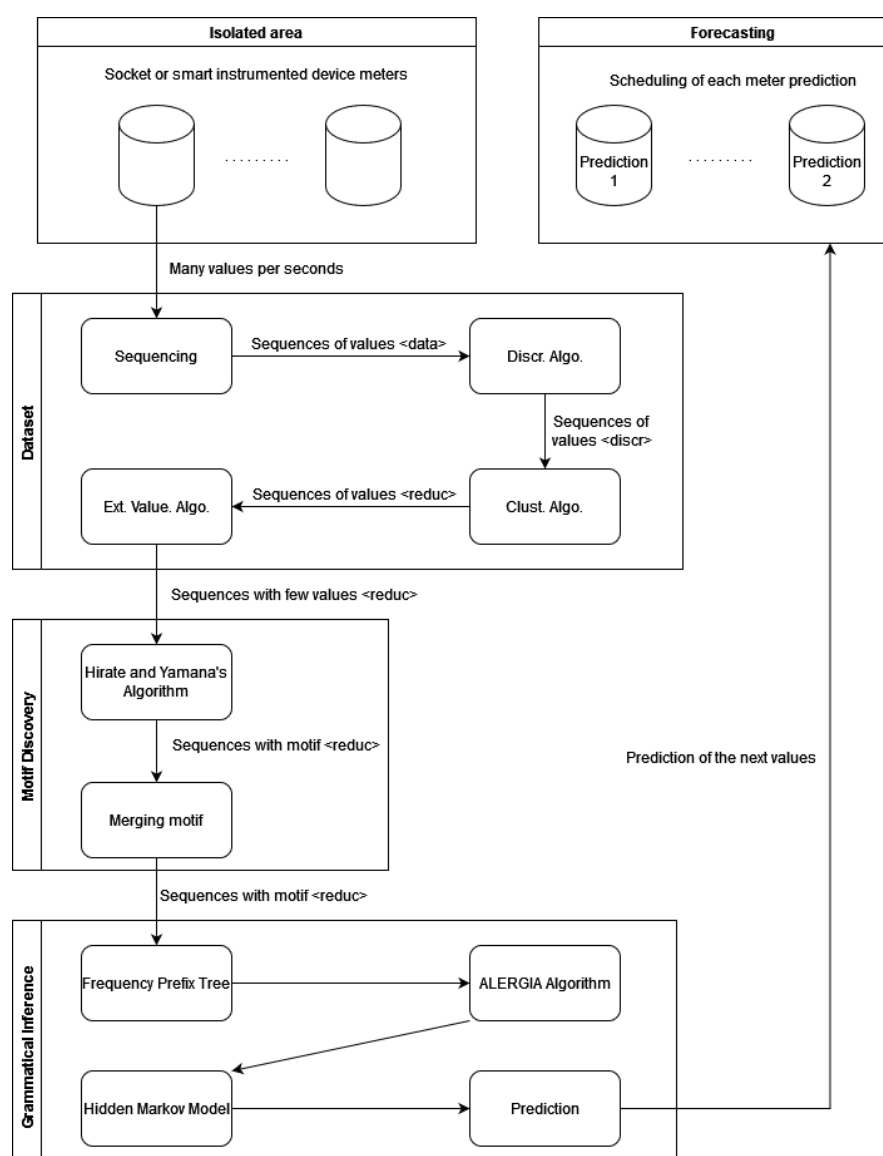
Figure 3. Overview of the